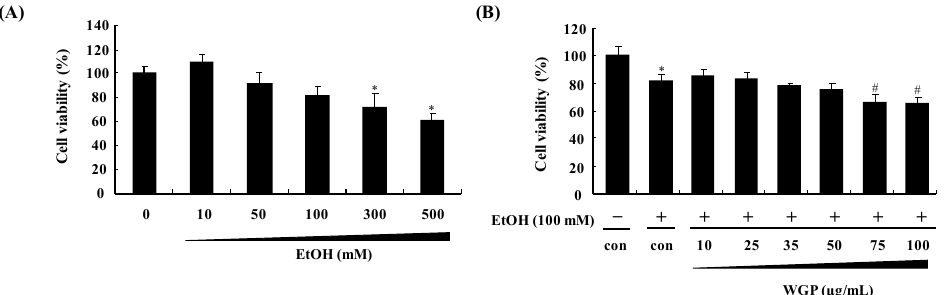
Figure 1. Cytotoxic effect of wild grape seed procyanidins (WGP) and ethanol on human hepatoma HepG2 cells. ( A ) Cells were treated with indicated concentration of ethanol (EtOH) for 24 h; and ( B ) cells were incubated with various concentrations of WGP in the presence of ethanol for 24 h. Cell viability was determined using MTT assay as described in materials and methods section. Cell viability was expressed as percentage of unstimulated-control cells. Values are means of three independent experiments ± SD ( n = 3). * p < 0.05 indicates differences from the unstimulated-control group; # p < 0.05 indicates differences from the ethanol-treated group.